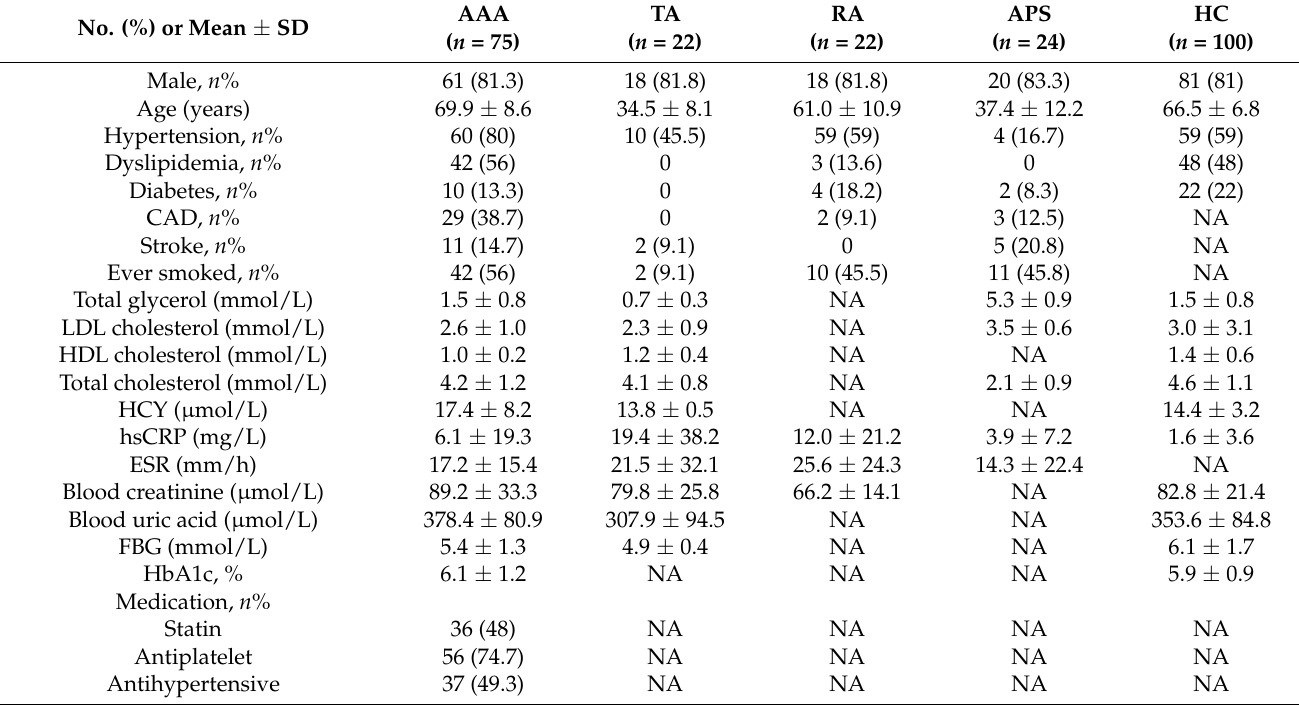
Table 1. Clinical characteristics of patients.